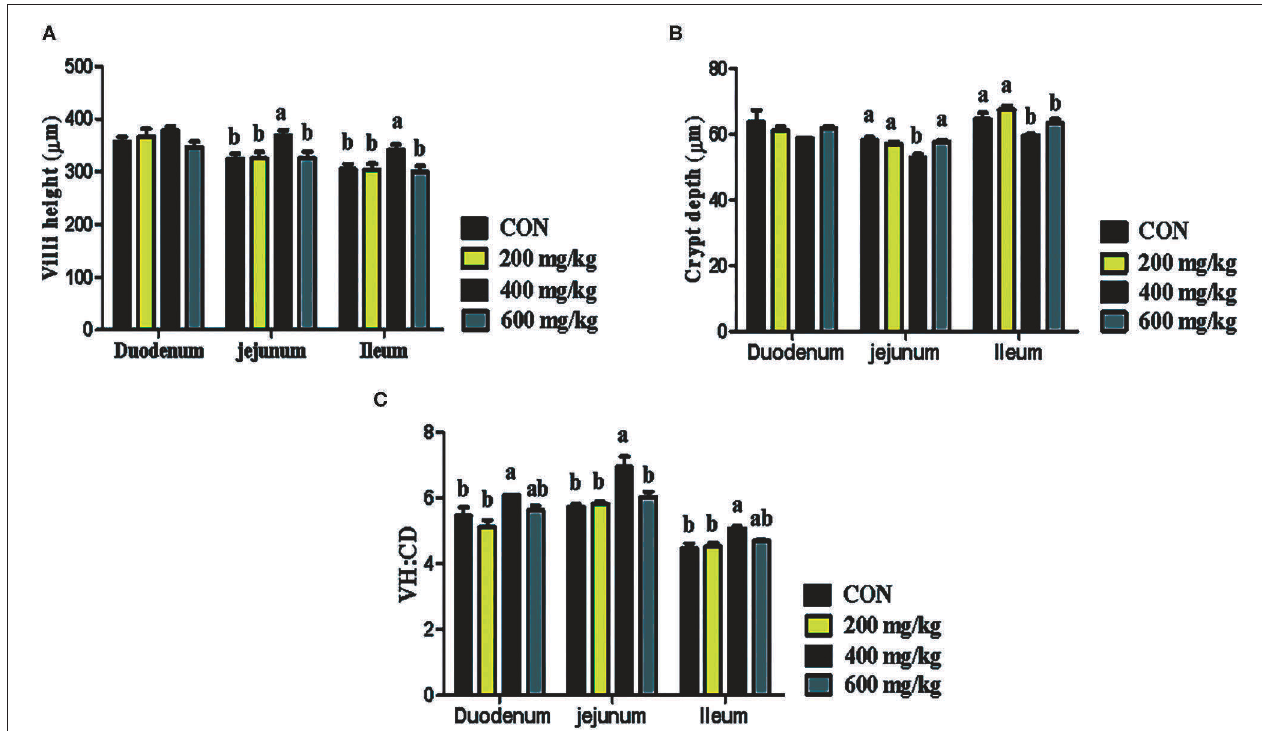
FIGURE 1 | Effects dietary bacteriophage supplementation on intestinal morphology ( A , Villi height; B , Crypt depth; C , VH/CD) of weaned piglets fed antibiotic-free diet ( n = 5). Con: the control diet supplemented with 25 mg/kg quinocetone and 11.25 mg/kg chlortetracycline in the basal diet; Treatments (200, 400, and 600 mg/kg): the treatment diets supplemented with 200, 400, or 600 mg/kg bacteriophage in the basal diet; a,b Different letters above bars indicates significant differences ( P <